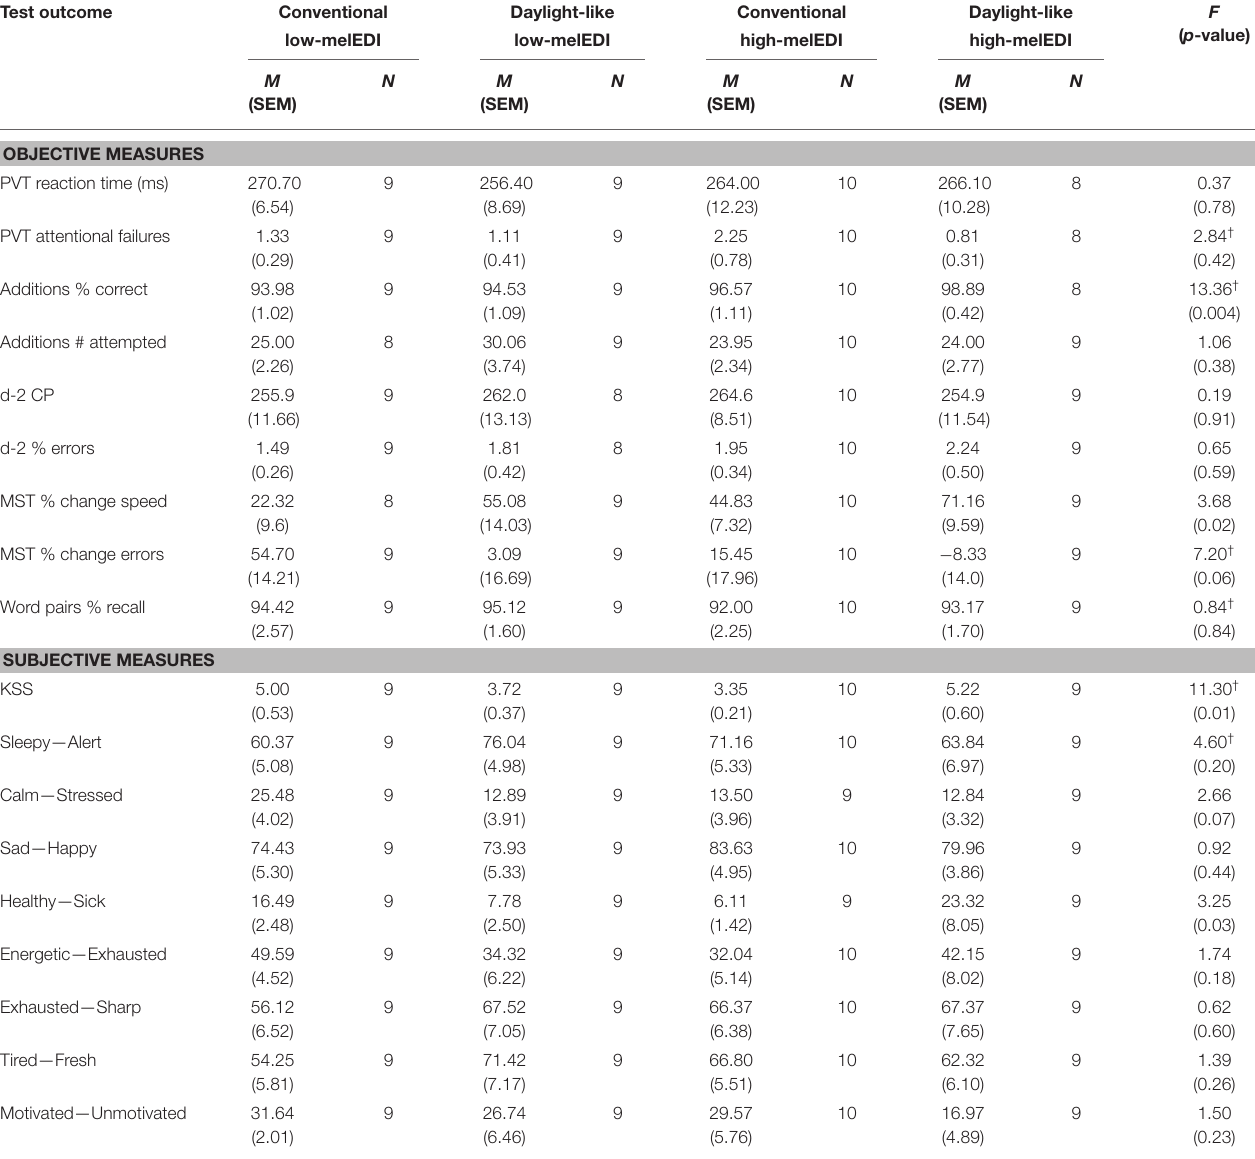
TABLE 2 | Mean SEM and ANOVA results for each test outcome*. ± Test outcome Conventional Daylight-like Conventional Daylight-like F